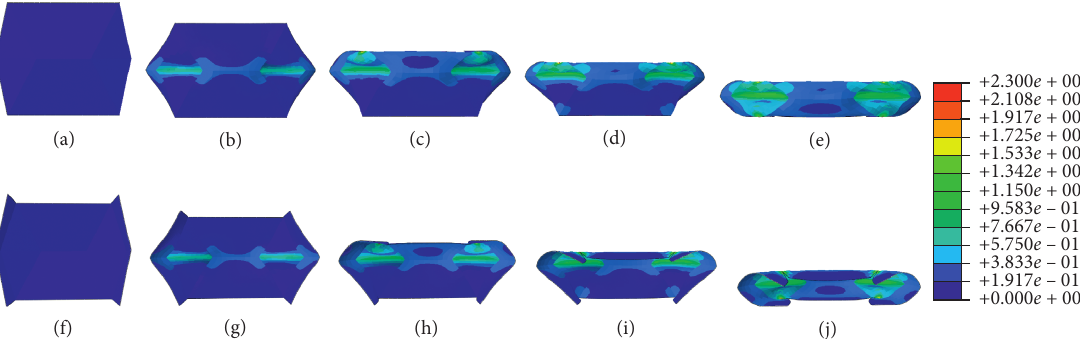
Figure 8: Plastic strain in deformation process: (a) main view of the device; (b) main view of the first ascending section; (c) main view of the first descending section; (d) main view of the second ascending section; (e) main view of the second descending section; (f) section view of the device; (g) section view of the first ascending section; (h) section view of the first descending section; (i) section view of the second ascending section; and (j) section view of the second descending